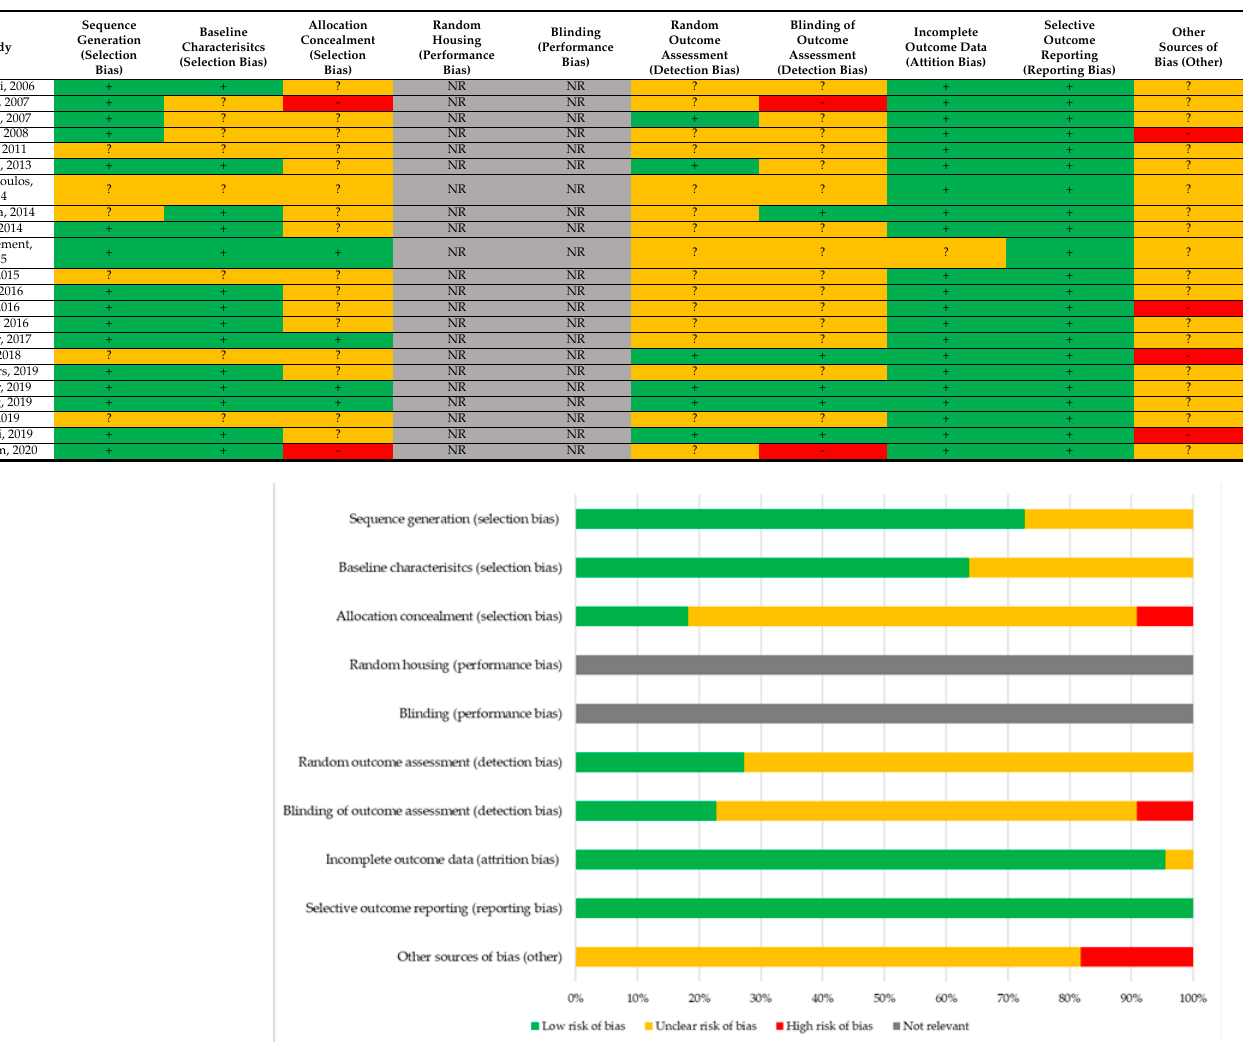
Table 2. SYRCLE’s risk of bias tool for animal studies.